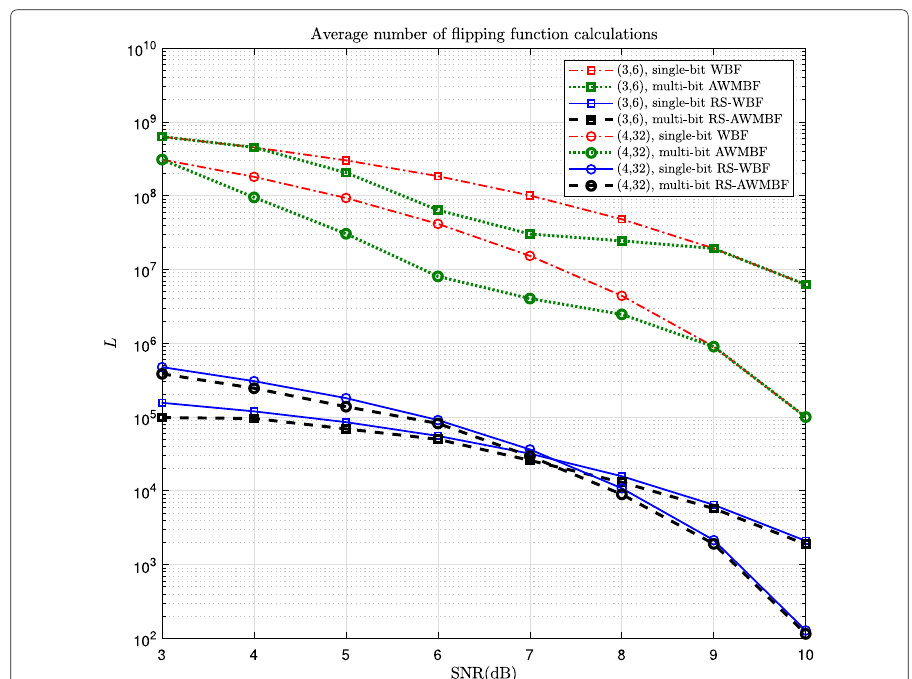
Fig. 4 L versus SNR for the (3,6) and (4,32)-regular codes with N = 10 5 and 81760,